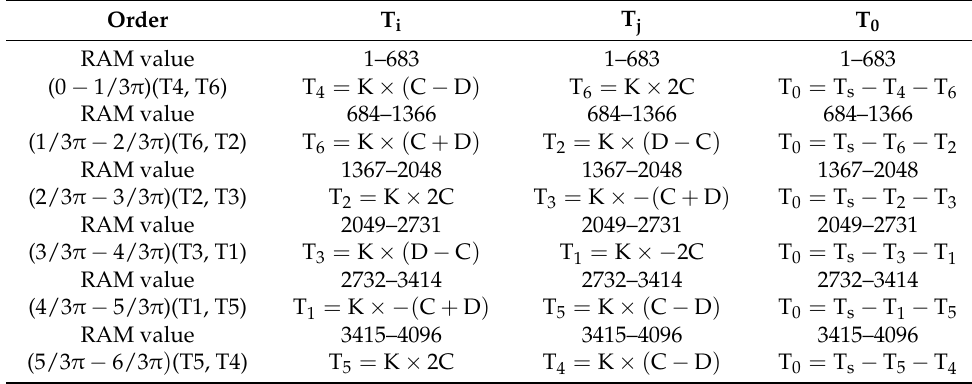
Table 8. The relationship between angle and action